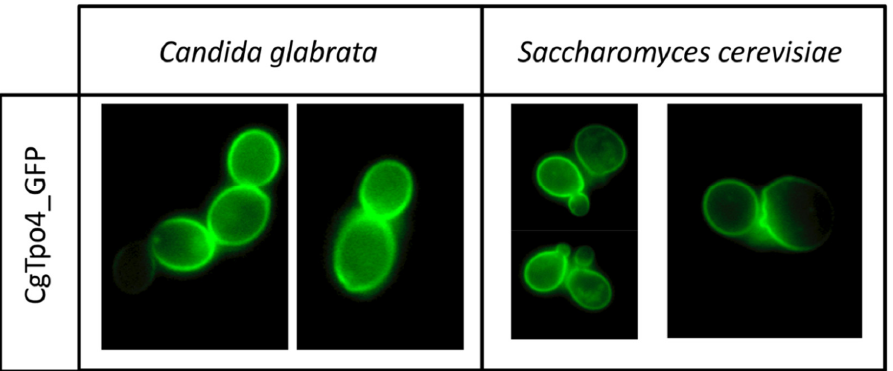
Figure 5. CgTpo4 is localized in the plasma membrane of yeast cells. Fluorescence of exponential-phase L5U1 C. glabrata cells or BY4741 S. cerevisiae cells, harboring the pGREG576_MTI_ CgTPO4 or pGREG576_ CgTPO4 plasmids, after 5 h of